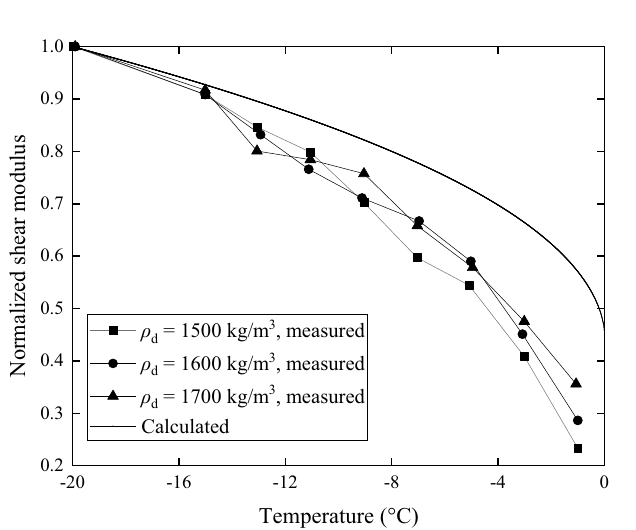
Figure 7. Relationships between frozen temperature and shear wave speed of ground with different soil water content (soil dry density ρ d = 1700 kg/m 3 ).